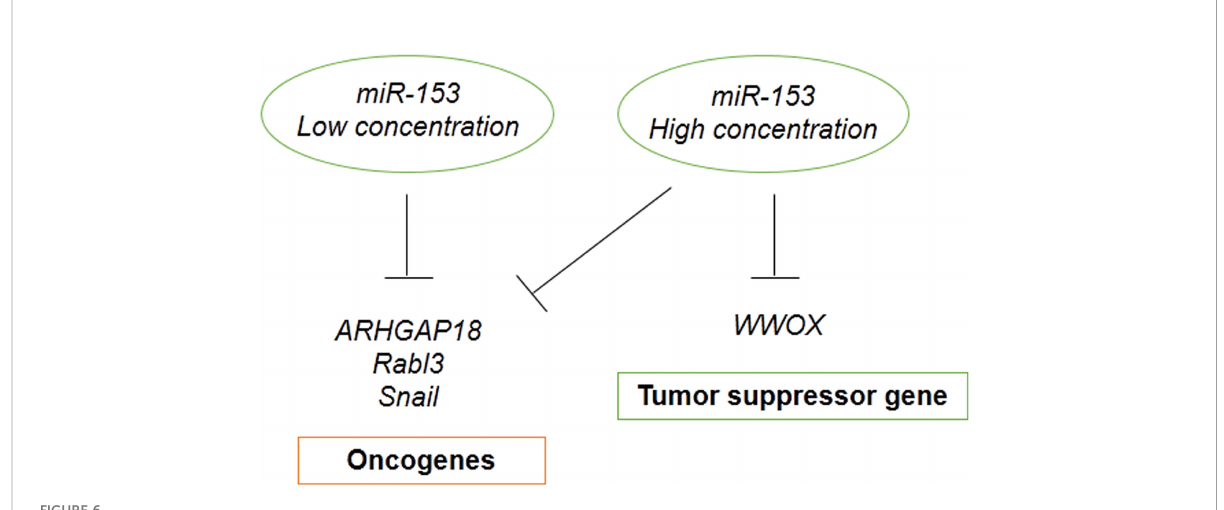
FIGURE 6 Dual role of miR-153 may be contributed to miRNA concentration and targets